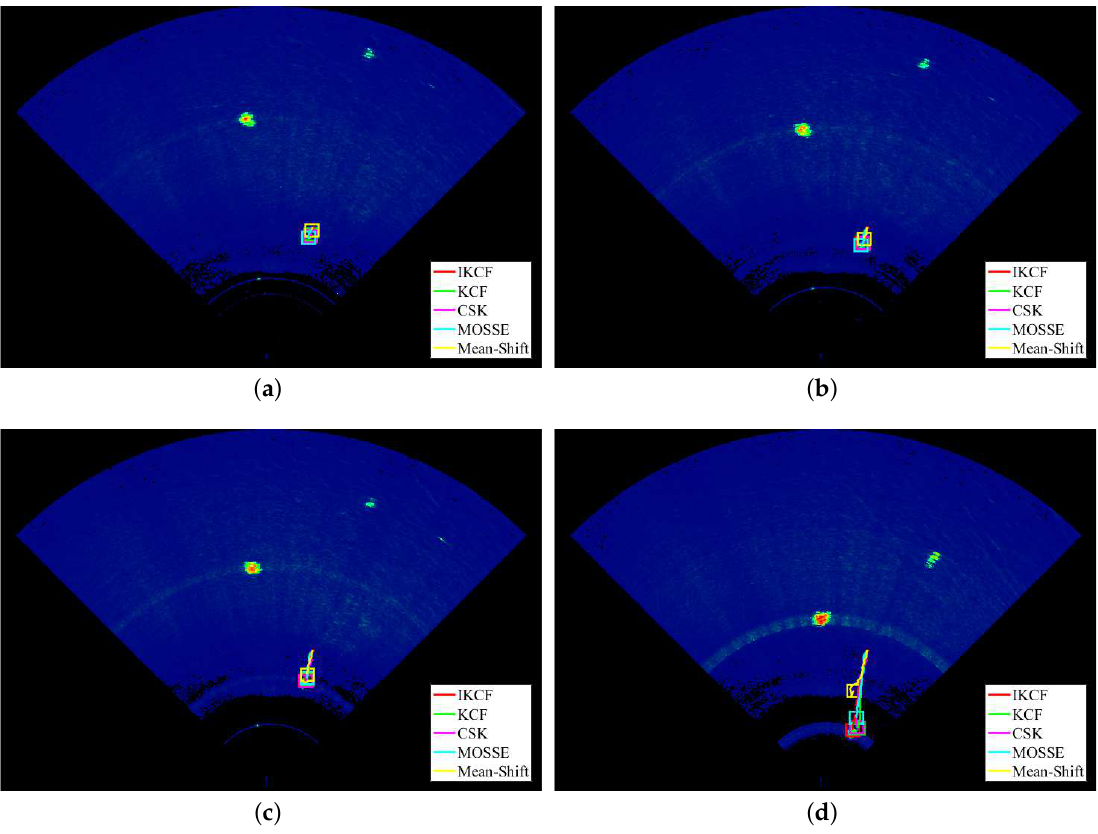
Figure 8. Tracking results for the target with varying scales: ( a ) The tracking results at the 1087th frame; ( b ) the tracking results at the 1093rd frame; ( c ) the tracking results at the 1112th frame; ( d ) the tracking results at the 1132nd frame.